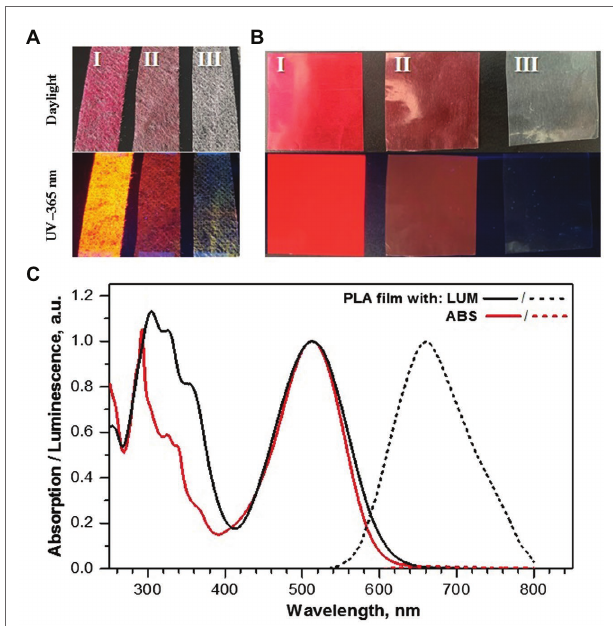
FIGURE 2 | (A–C) Photographs of (A) agrotextiles (pieces 2 × 5 cm in size) and (B) pressed PLA films (3 × 3 cm) under daylight and irradiation with UV = 365 nm: I—with LUM (w/w 0.25%); II—with ABS (w/w 0.25%); III— reference sample, PP + PLA textile, and PLA film, respectively. (C) Normalized absorption (solid) and luminescence (dashed) spectra of PLA films (thickness is ca. 40 μ m) containing (w/w 0.25%) luminophore LUM or absorbent